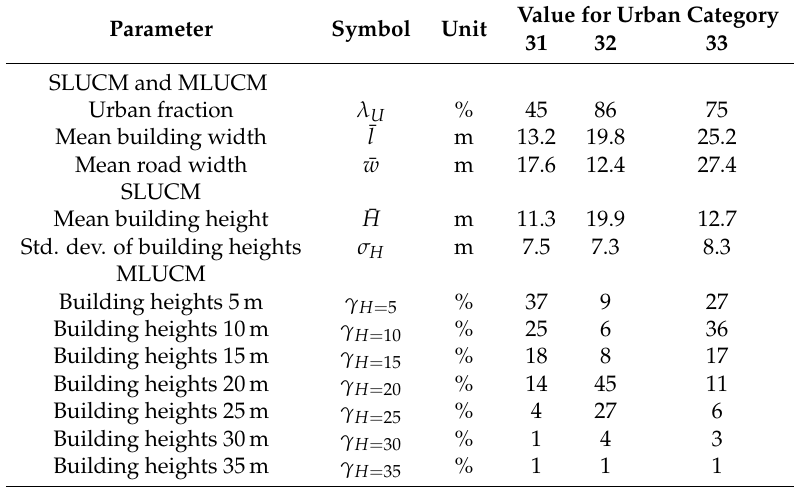
Table 4. Urban morphology parameters used in the urbanized WRF simulations (SLUCM or